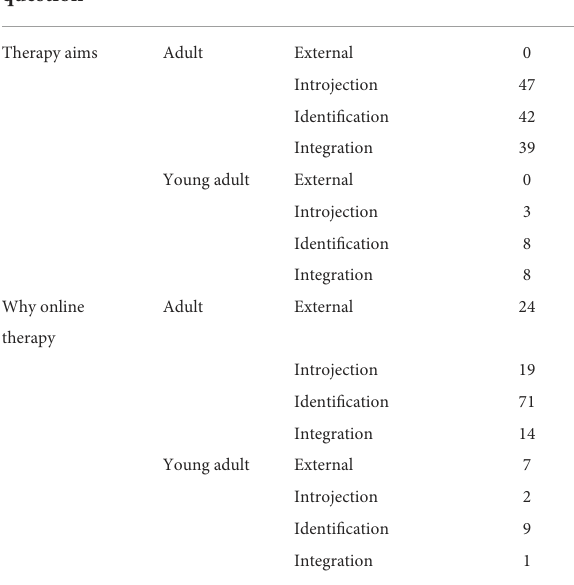
TABLE 4 Distribution of motivation type, by motivational question and age